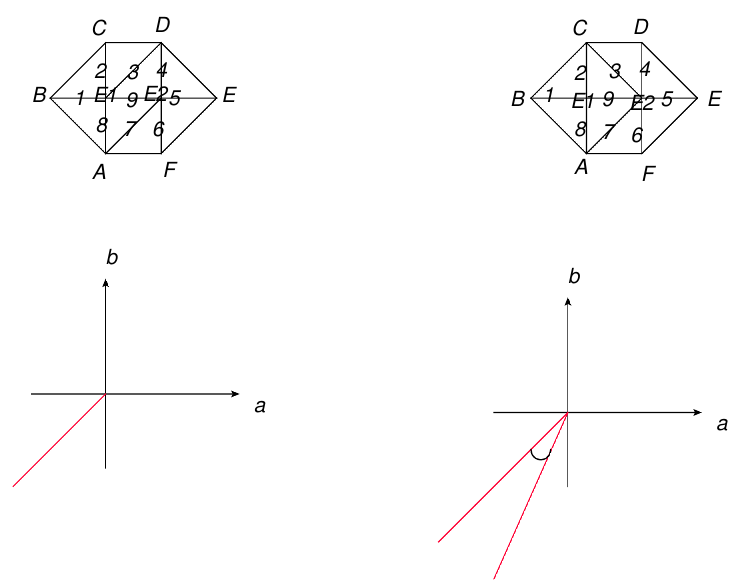
Figure 11 . Two resolutions of a toric diagram and its